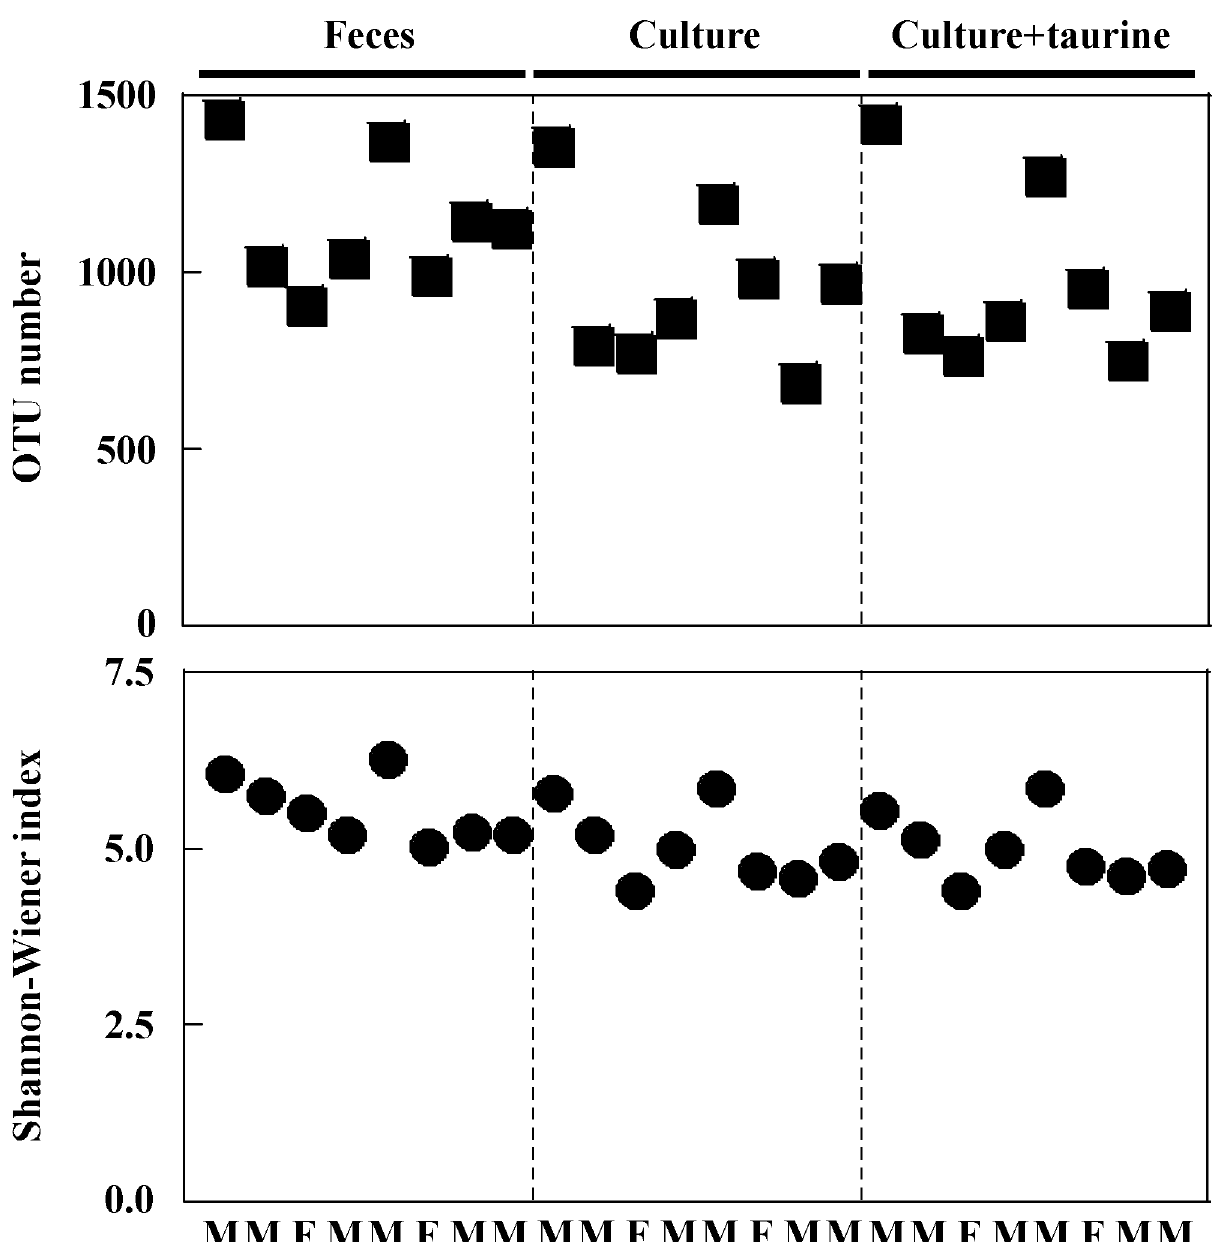
Fig 2. Comparison of operational taxonomic unit (OTU) number and bacterial diversity (Shannon-Wiener index) among original fecal samples and respective KUHIMM cultures grown in the absence or presence of taurine following inoculation with one of each of the fecal samples from 8 human subjects (M39, M38, F40, M43, M60, F62, M25, and